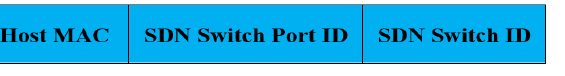
Figure 3. Host link format.